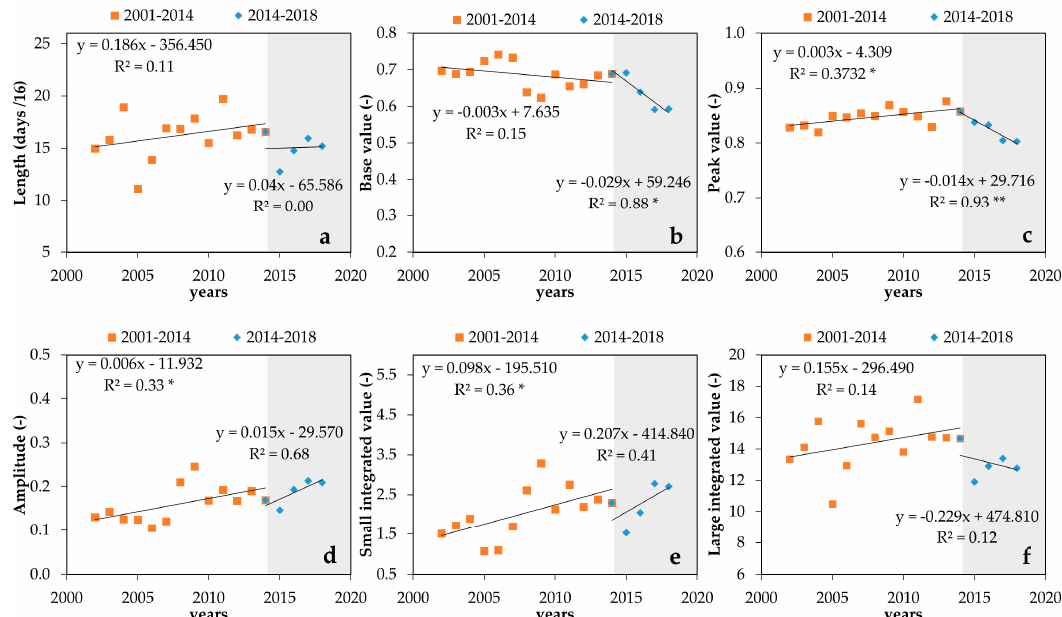
Figure 10. Seasonal parameters in CS3: ( a ) length value, ( b ) base value, ( c ) peak value, ( d ) amplitude value, ( e ) small seasonal integral and ( f ) large seasonal integral. The grey areas refer to the time interval when corrective measures have been implemented for facing CTV. Significant p -value ( p < 0.05, 0.01 and 0.001) are indicated with *, ** and ***, respectively.